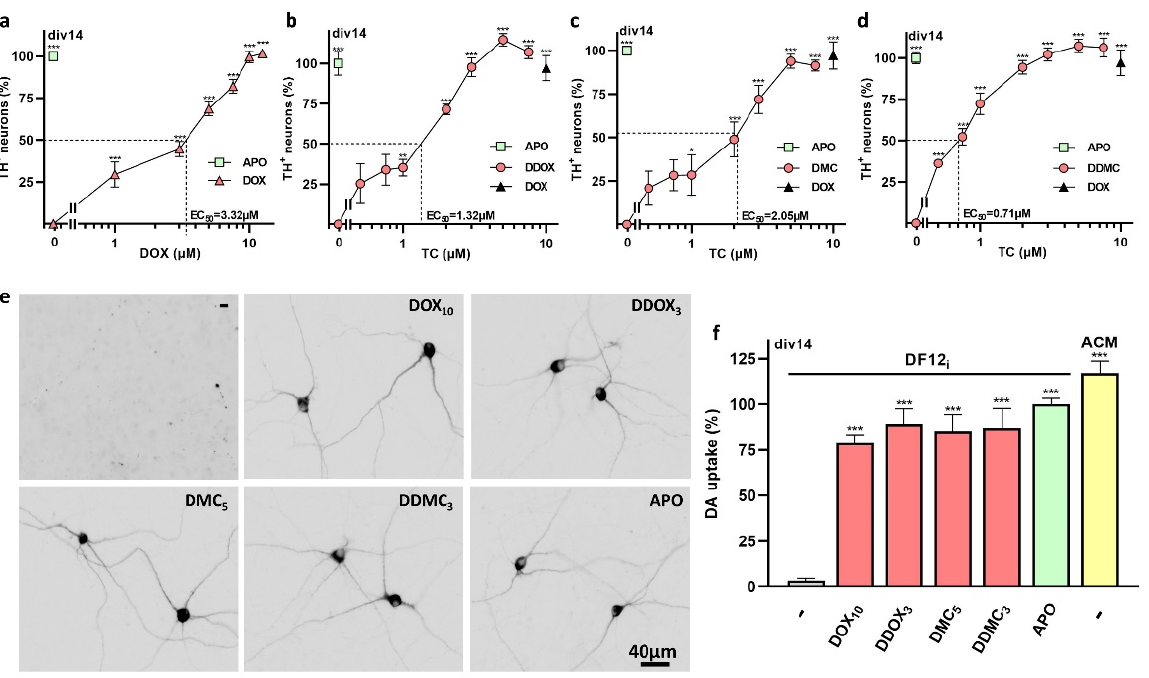
Figure 10. TC derivatives preserve the survival and function of mature DA neurons enduring low- level iron-mediated neurodegeneration. ( a – d ) Concentration–response curves of the rescue effects of DOX , DDOX , DMC, and DDMC for DA neurons, in div14 midbrain cultures, which have been gradually placed since div7 in DF12i supplemented with 2 µM MK-801. APO (100 µg/mL) was used as a reference neuroprotectant. EC 50s for each TC are indicated on the graph above. Data expressed in % of APO-treated cultures are means ± SEM (4–9). * p < 0.05, ** p < 0.01, *** p < 0.001 vs. NT. One-way ANOVA followed by Dunnett’s test. ( e ) Microphotographs illustrating the protective effects of DOX (10 µM), DDOX (3 µM), DMC (5 µM), DDMC (3 µM), or APO (100 µg/mL) in mature mid- brain cultures. ( f ) DA uptake in div14 midbrain cultures that were gradually placed since div7 in DF12i supplemented with 2 µM MK-801 in the presence or absence of DOX (10 µM), DDOX (3 µM), DMC (5 µM), DDMC (3 µM), or APO (100 µg/mL). As a comparison, the uptake was also performed in cultures maintained in ACM during the entire culture time. Data expressed in % of APO-treated cultures are means ± SEM (8–18). *** p < 0.001 vs. NT. One-way ANOVA followed by Dunnett’s test.